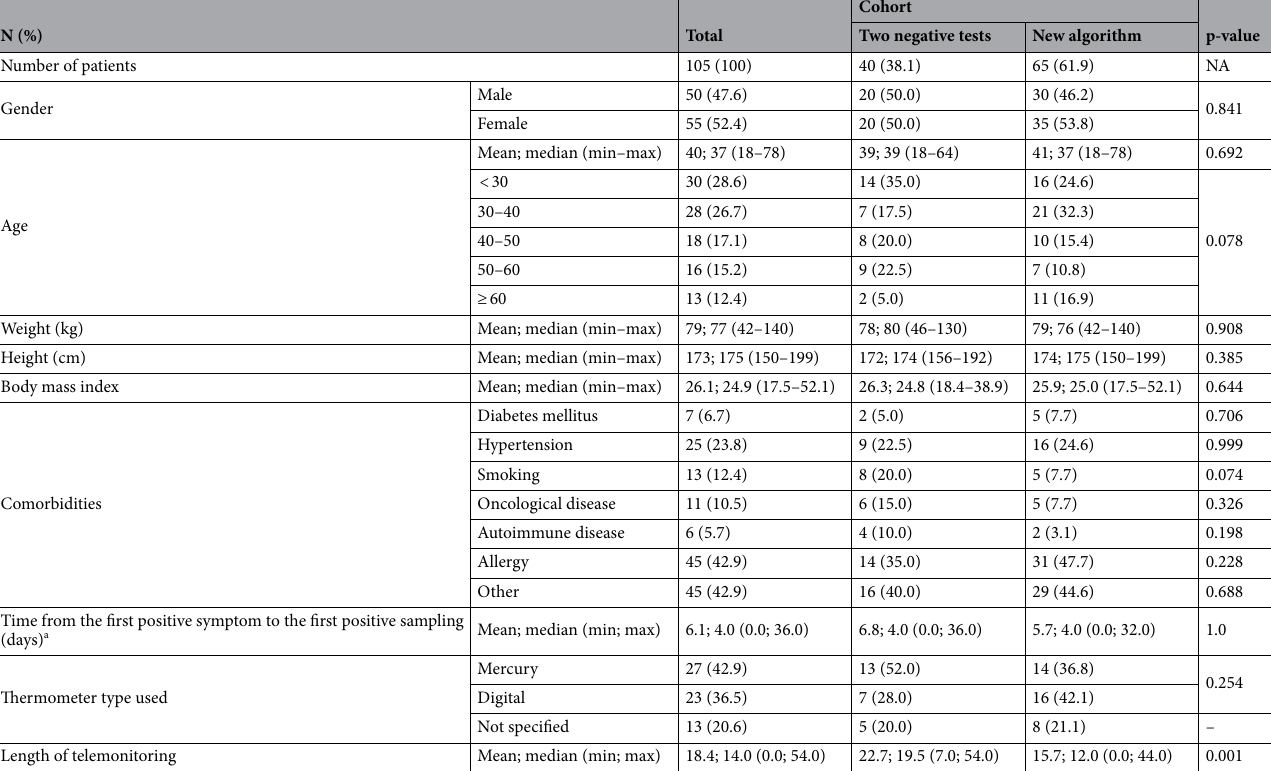
Table 1. Characteristics of outpatients enrolled in the study. a Only patients with any symptom at the time of sampling included (i.e. without 14 asymptomatic patients at the time of